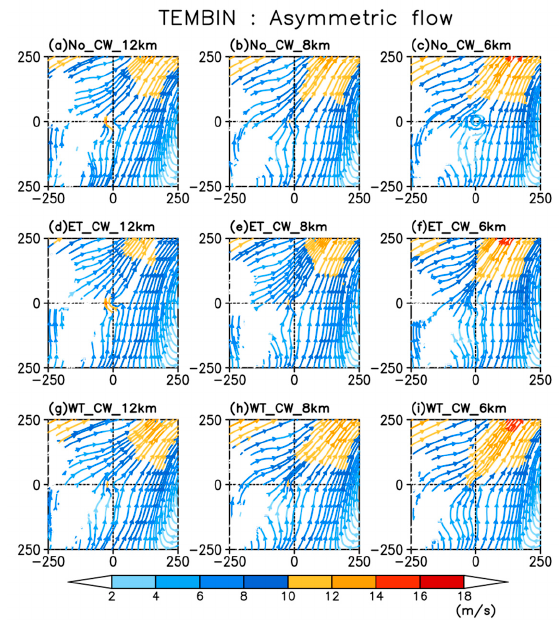
Figure 6. The 12-h averaged lower-level (900 hPa–550 hPa) asymmetric flow in the Typhoon Tembin core region (250 km × 250 km) over periods (48–60 h) in ( a ) No_CW_12 km, ( b ) No_CW_8 km, ( c ) No_CW_6 km, ( d ) ET_CW_12 km, ( e ) ET_CW_8 km, ( f ) ET_CW_6 km, ( g ) WT_CW_12 km, ( h ) WT_CW_8 km and ( i ) WT_CW_6 km experiment of Typhoon Tembin.